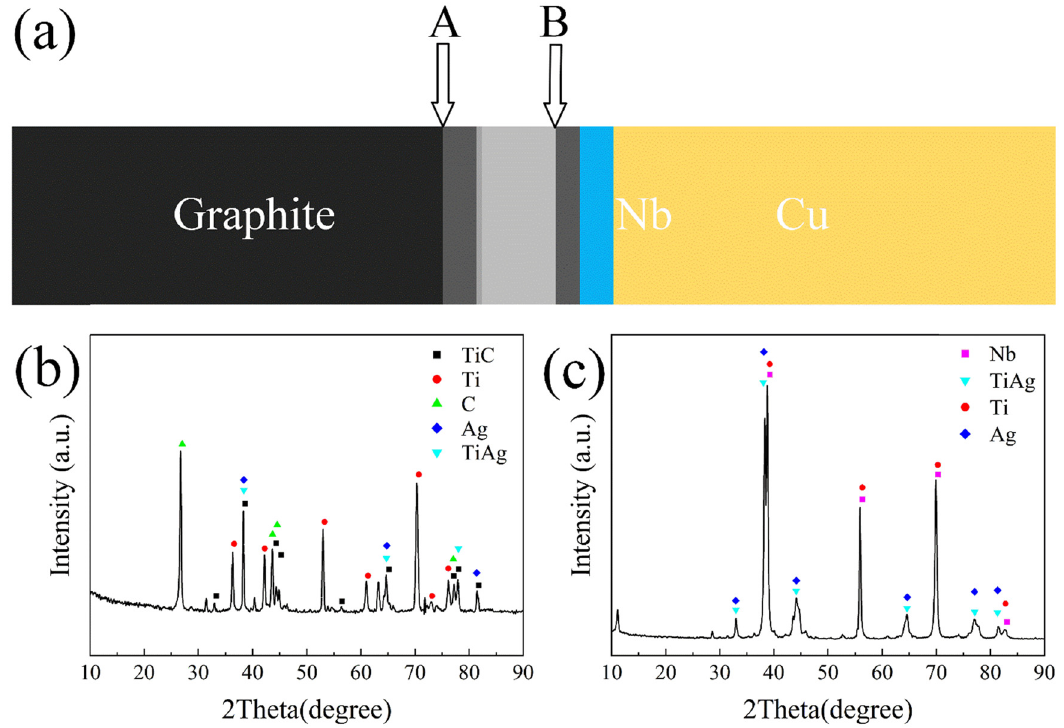
Figure 3: Schematic of the positions of graphite/Cu joints ( a ) and the corresponding XRD analysis: ( b ) Plane A and ( c ) Plane